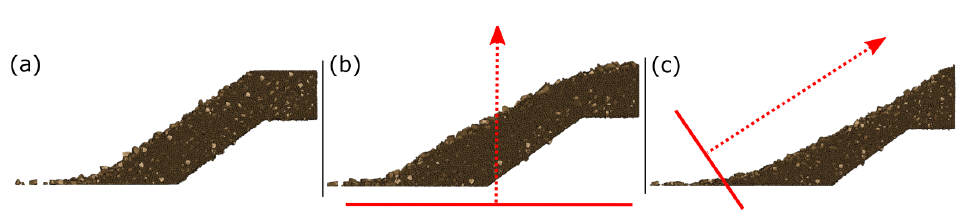
Figure 8. A side view of the three different muck-piles. ( a ) the original muck-pile, rearrangement of the original muck-pile by moving a plate vertically ( b ), and at an angle ( c ). The thick line represents the plate, and the arrow the direction of movement.